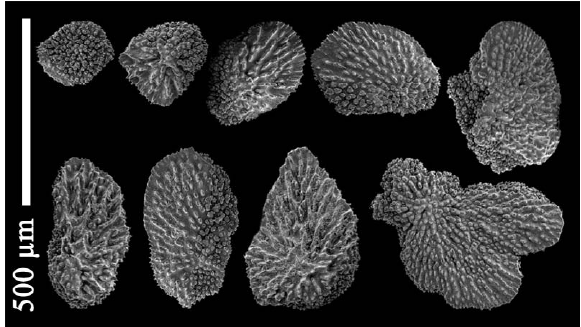
Fig . 13. – Thouarella andeep n. sp., holotype ZiZMH c11744 : coe- nenchymal